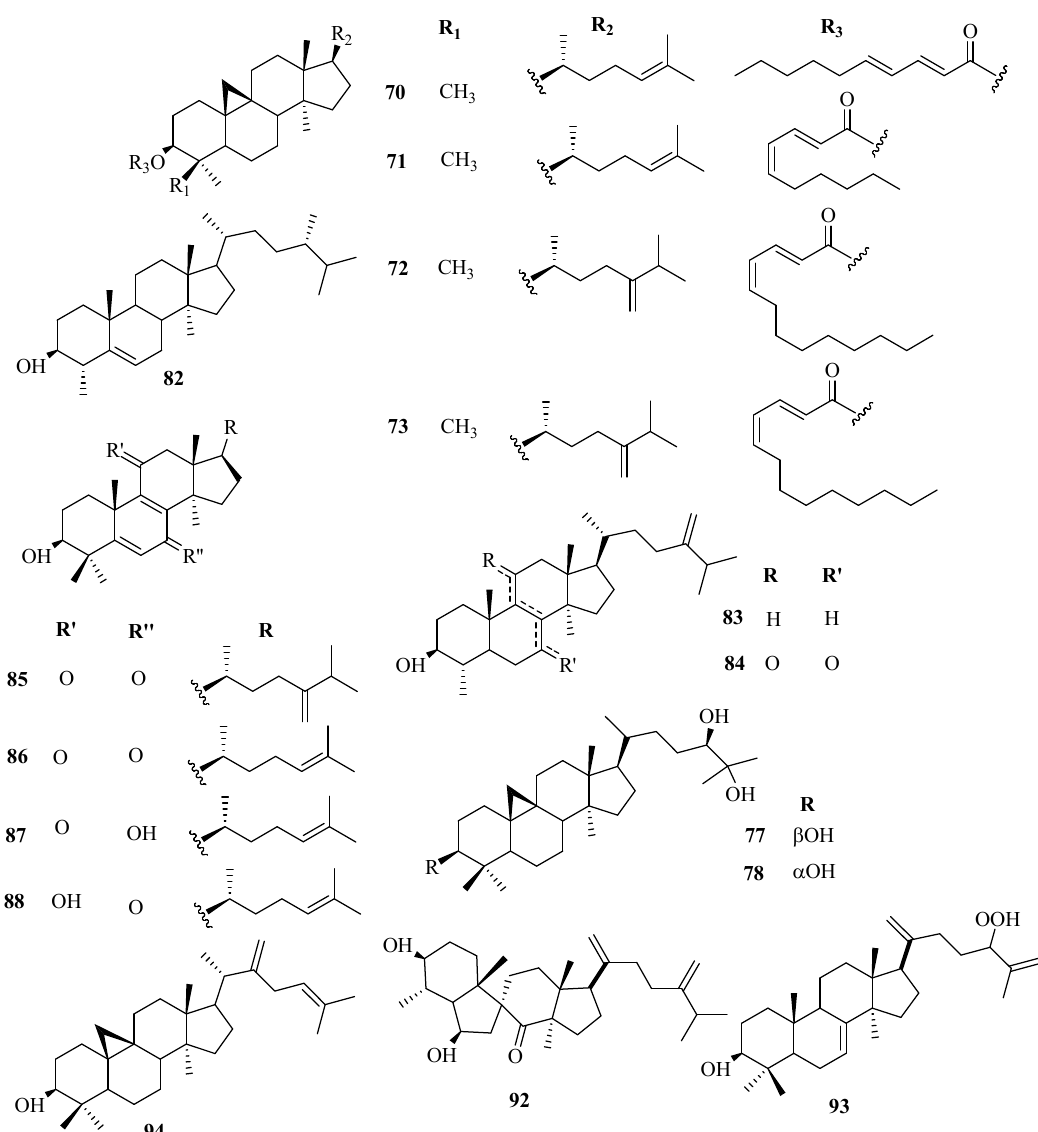
Figure 4. Structures of cycloartane and lanostane triterpenoids isolated from genus Euphorbia.